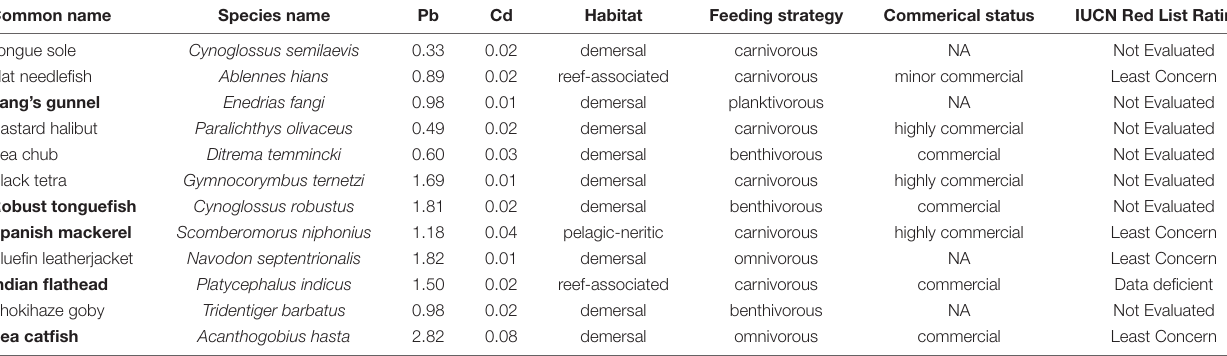
TABLE 3 | Potential fish bioindicator species in the Liaodong